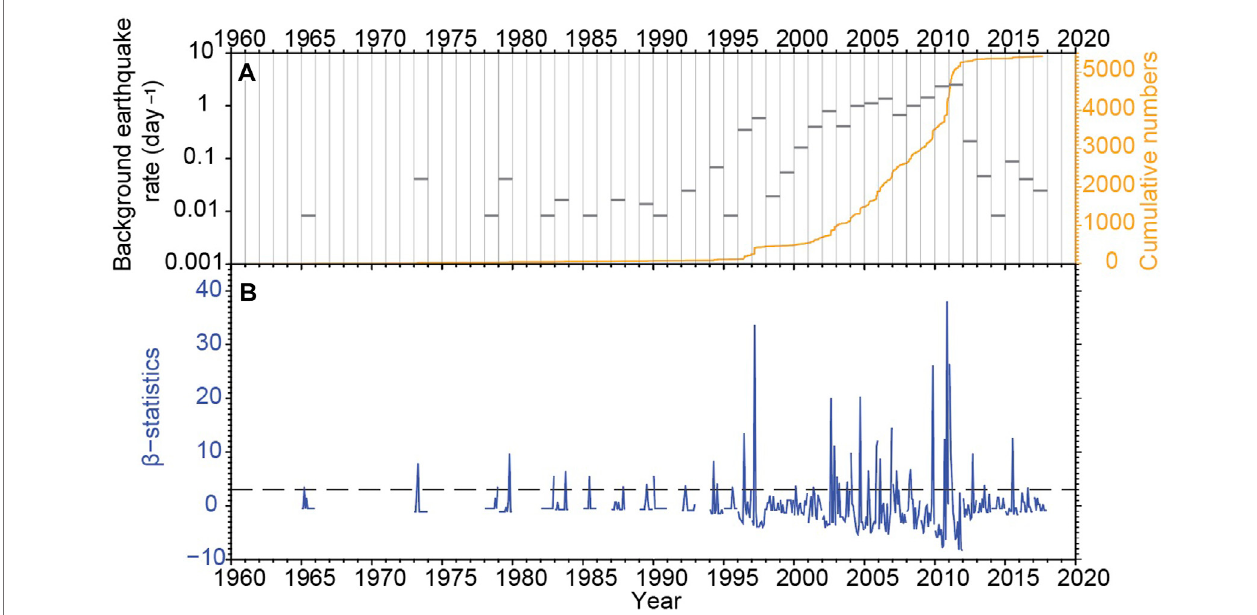
FIGURE2| BackgroundseismicityrateandearthquakeswarmdetectionforGulfofAden. (A) Horizontalbarsindicatetheestimatedbackgroundseismicityratefor each year, with gaps representing years with no earthquakes in the catalogue. The cumulative number of earthquakes is shown by the orange curve. (B) The beta statistics calculated for non-overlapping windows of 30 days is shown in dark blue, with gaps re fl ecting lack of earthquakes in the catalogue. The horizontal dashed line representstheswarm-detectionthreshold valueof3standarddeviations.Notethattheimprovedmonitoringislikelyaccountingforsomeoftheseismicityincrease (see Supplementary Figure S2 for more information).